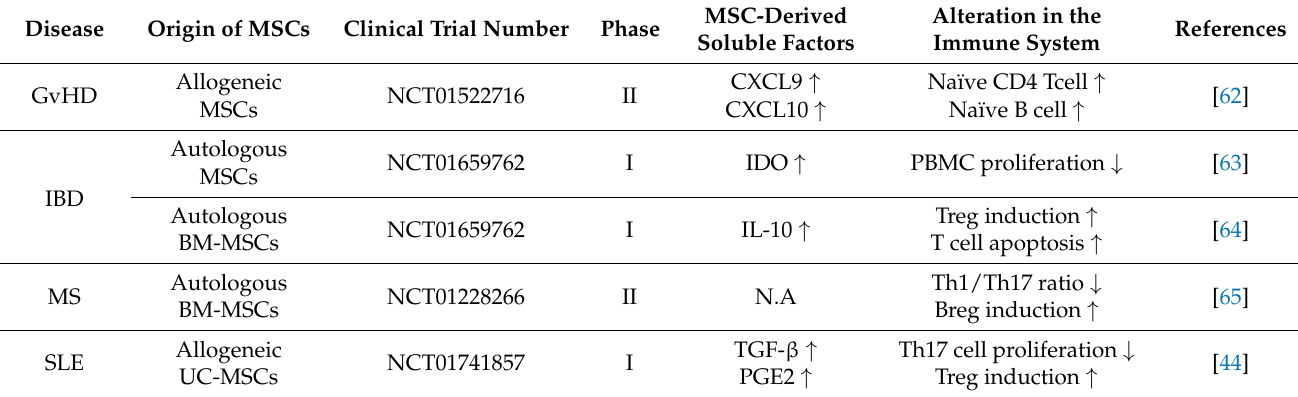
Table 1. Examples of clinical trials for the treatment of immune-mediated diseases using MSCs. Disease Origin of MSCs Clinical Trial Number Phase